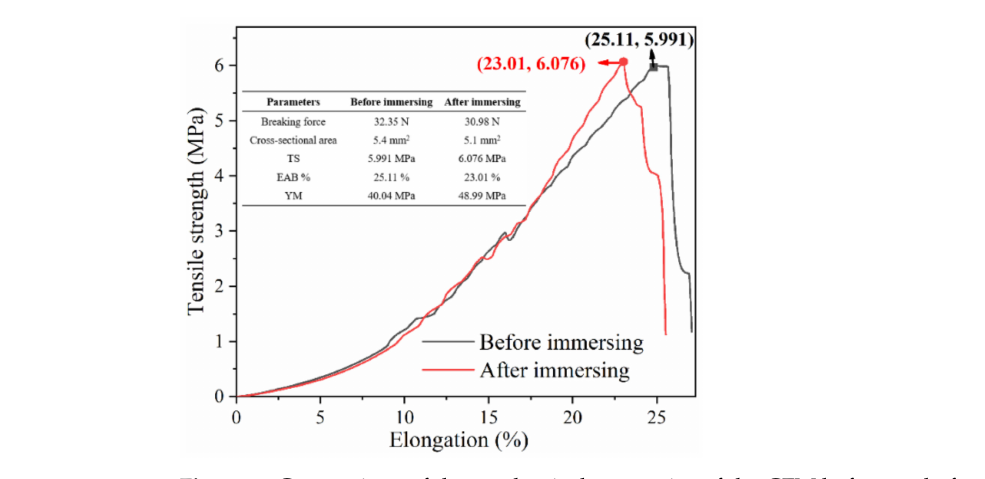
Figure 6. Comparison of the mechanical properties of the CFM before and after immersion in the ionic liquid.